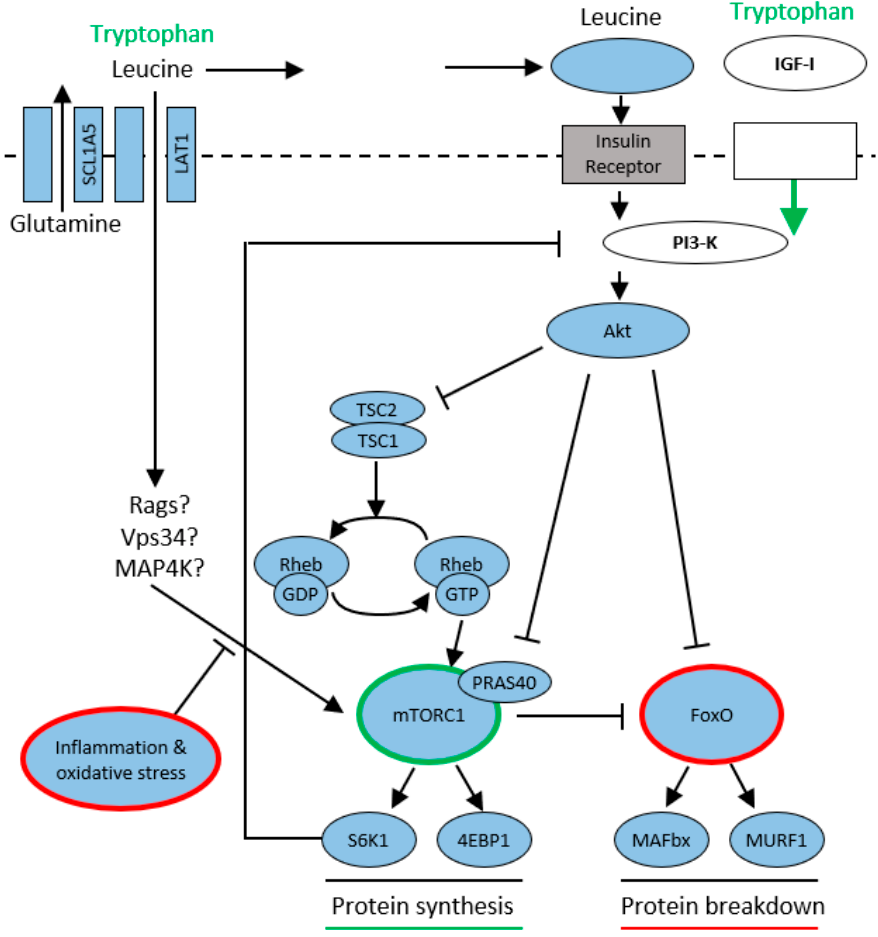
Figure 5. Tryptophan modulates mTORC1/protein synthesis according to [35]. Tryptophan modu- lates protein synthesis via 2 pathways: (1) IGF-I to PI3-K to Akt to mTORC1; (2) insulin independent mechanism, likely involves Rag, Vps34, MAP4K3. Protein breakdown modulates FoxO. Inflammation and oxidative stress attenuate the activation mTORC1, leading to muscle wasting.